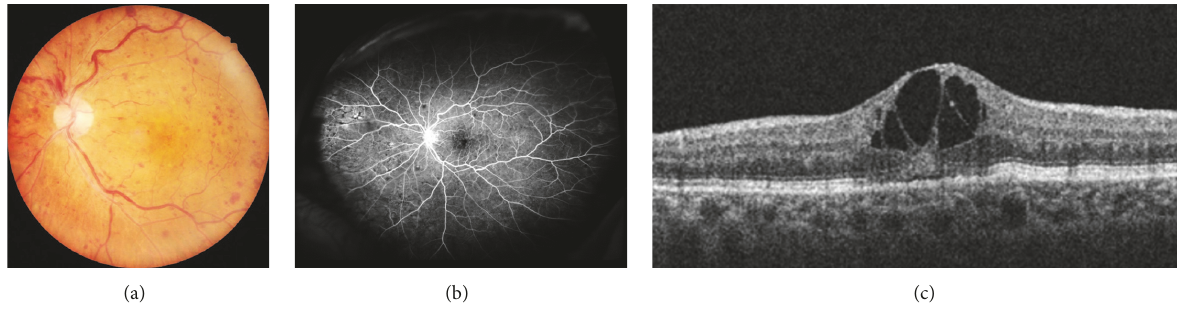
Figure 1: Image findings in the left eye at initial visit. (a) Fundus photograph demonstrating venous tortuosity and intraretinal hemorrhage in all four quadrants of the funds. (b) Fluorescein angiography demonstrating an intact parafoveal capillary network. (c) Optical coherence tomography demonstrating inner retinal cysts.